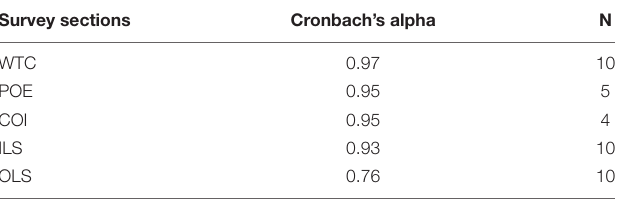
TABLE 4 | Mann-Whitney U -test results.